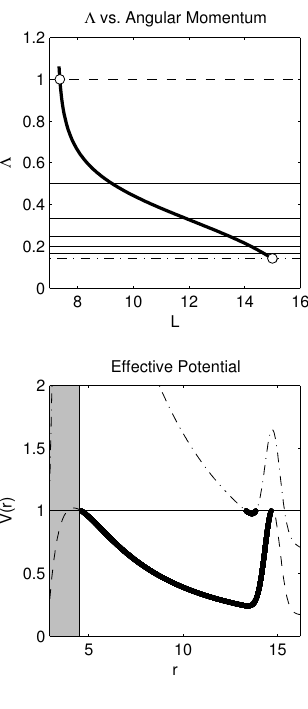
Figure 1. Top panel: Λ as a function of angular momentum L is plotted for E = ω ∞ = 1 as the thick black line. On this panel we plot the value of Λ = 1 as a dashed line, 1/2, 1/3, 1/4, 1/5, 1/6 as thin solid lines and Λ = 1/7 as a dash-dotted line. The intersections of the Λ = 1 and Λ = 1/7 lines with Λ ( L ) are marked as white discs. The effective potential corresponding to the angular momentum specified by these discs are plotted in the lower panel. The shaded region represents the interior of the CO and the heavy black lines are the effective potentials experienced by the ray. The Λ = 1 and Λ = 1/7 cases are represented by dashed and dash-dotted lines respectively.